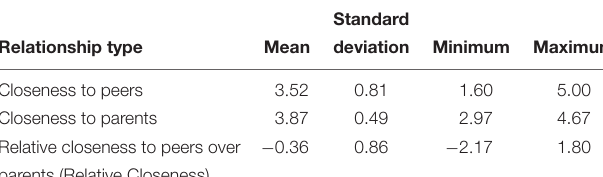
TABLE 1 | Closeness with peers, closeness with parents, and Relative Closeness scores on the